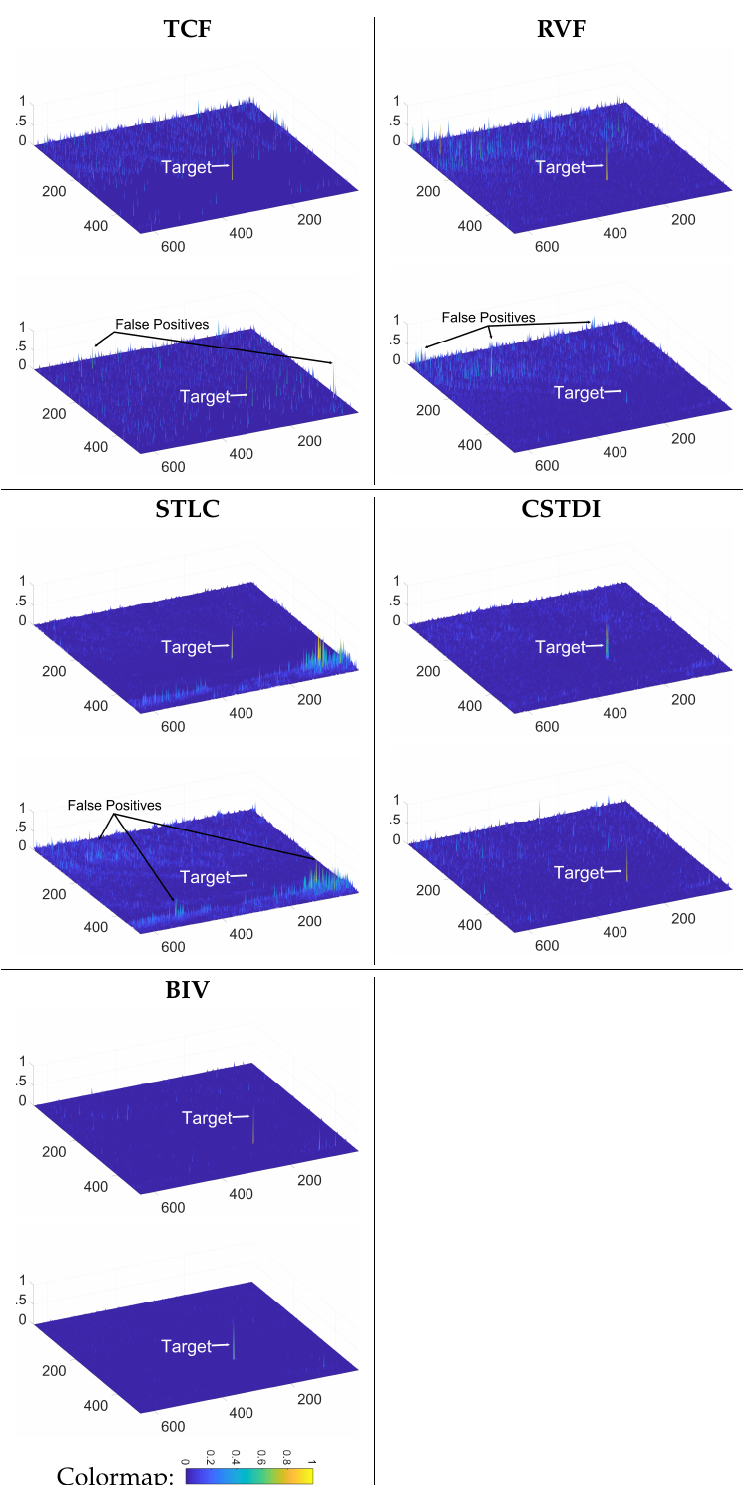
Figure 6. Detection outputs of spatiotemporal methods. The upper detection map in each cell is for the image in Figure 3a while the lower detection map is for the image in Figure 3b. Traditional approaches produced greater false alarms and could miss the target. The biologically inspired methods (CSTDI and BIV) overcome both issues showing better robustness than the other methods, with the BIV target detector even better at supressing false alarms than the